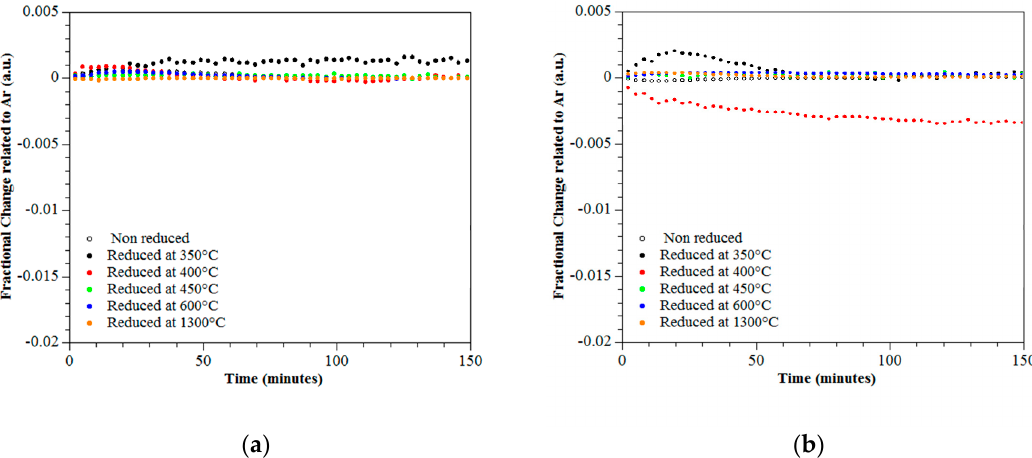
Figure 7. Fractional change of CO 2 over 150 min under UV of wavelengths ( a ) 376–387 nm and ( b ) 381–392 nm.